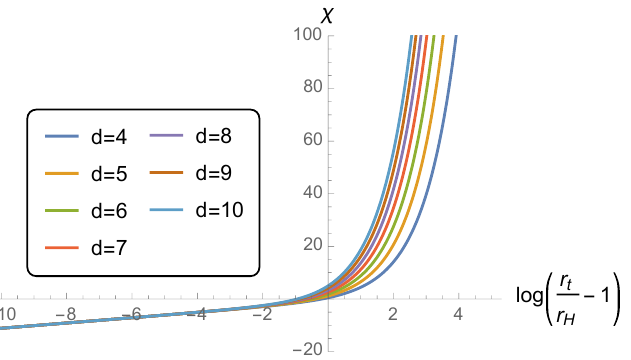
Figure 3 . Same as (cid:12)gure 2, but for a d + 1-dimensional asymptotically (cid:13)at Schwarzschild black hole. The divergent behaviour implies we must impose a cuto(cid:11) to control the how large (cid:31) becomes. The cuto(cid:11) is implemented using the low frequency criterion discussed in section